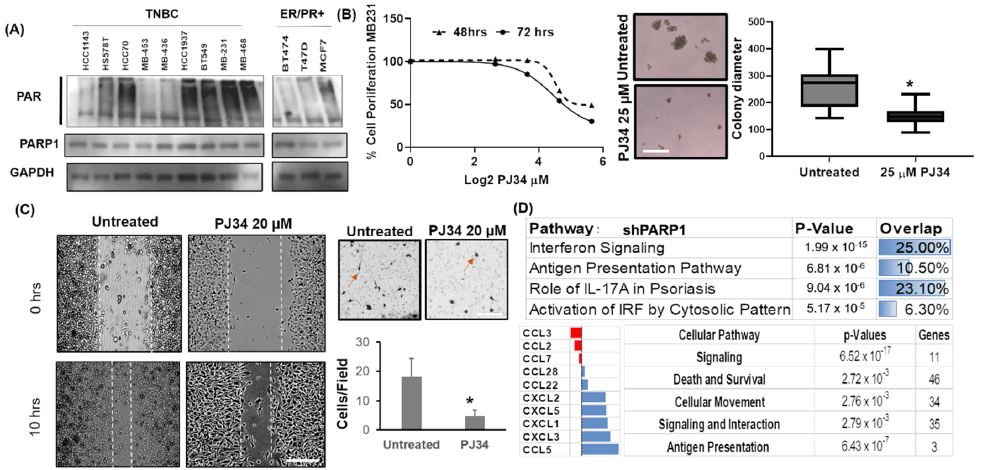
Figure 1. PARP1 inhibition resulted in reduced cell proliferation and migration in breast cancer cells. ( A ) Western blots for total levels of PARP1 and PolyADP Ribose (PAR) in a panel of breast cancer cells. Triple-negative cell lines are on the left. GAPDH is used as a loading control. Whole western blots for 1A are in Figure S9 ( B ) Left: Cell proliferation upon PJ34 PARP inhibitor treatment in MB-231 cells at 48 h and 72 h. Right: Colony formation assay with PJ34 treated MB-231 cells in low attachment plates for 7 days. Scale bar 10 µm ( C ) Left: Wound healing assay in the presence of PJ34 in MB-231 cells. Right: Boyden chamber Invasion assay in the presence of PJ34 inhibitor using MB-231 cells. Cells were incubated with PJ34 for the duration of the experiment. Experiments were done in duplicate two times. Dark objects on the pictures are cells. One arrow is shown in each panel, pointing to one of the cells. * p < 0.05 × 2 test in ( C ). Scale bar 50 µm (left) and 10 µm (right). Enlarged view in Figure S12. ( D ) Ingenuity pathway analysis (IPA) for Canonical pathways with PARP1 knockdown in BT549 cells. IPA was used on differentially expressed genes after whole transcriptome sequencing. Overlap showing the % of differentially expressed genes that belong to the pathways shown. Chemokines showed in ( D ) bottom left show similar patterns of expression with PARP1 knockdown. The color bars below indicate downregulation (red) and upregulation (blue) with PARP1 knockdown. Log2 fold change is represented by the color bars. “Genes” column bottom right showing several differentially expressed genes that belong to the molecular pathway category.